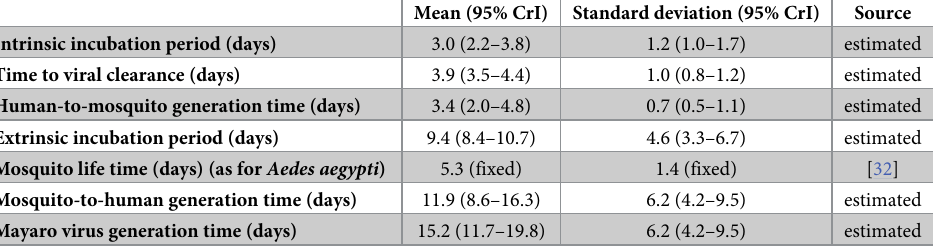
Table 3. Estimates of the mean and standard deviation of the generation time distribution and its